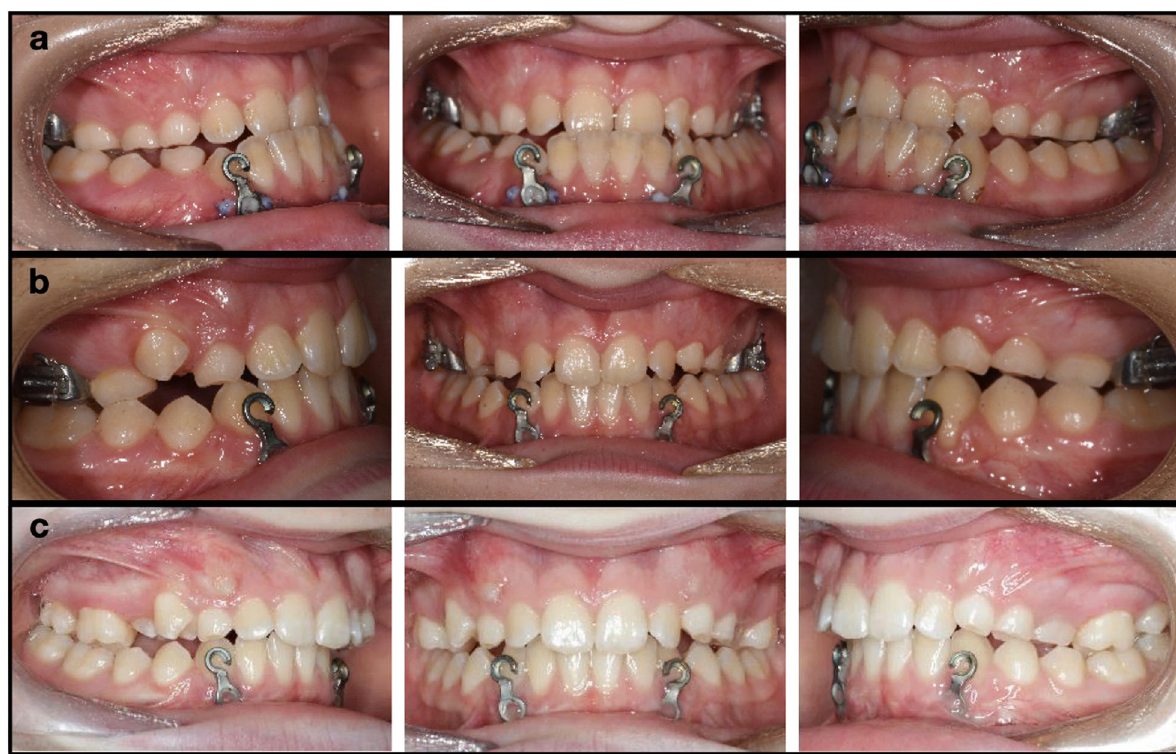
Fig.5 Progression of the case from the HE-MP group from start to finish. A Start of elastic wear after conversion of the miniplates into a hooks; B 7 months’ progress with positive overjet developing; C Treatment finished at 14 months with a positive overjet and slightly overcorrected molar